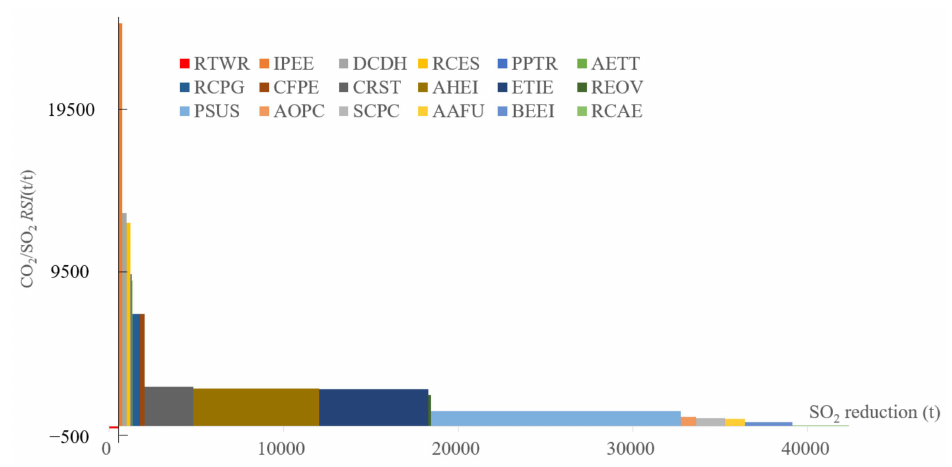
Figure 13. SRC of SO 2 and CO 2 emissions in